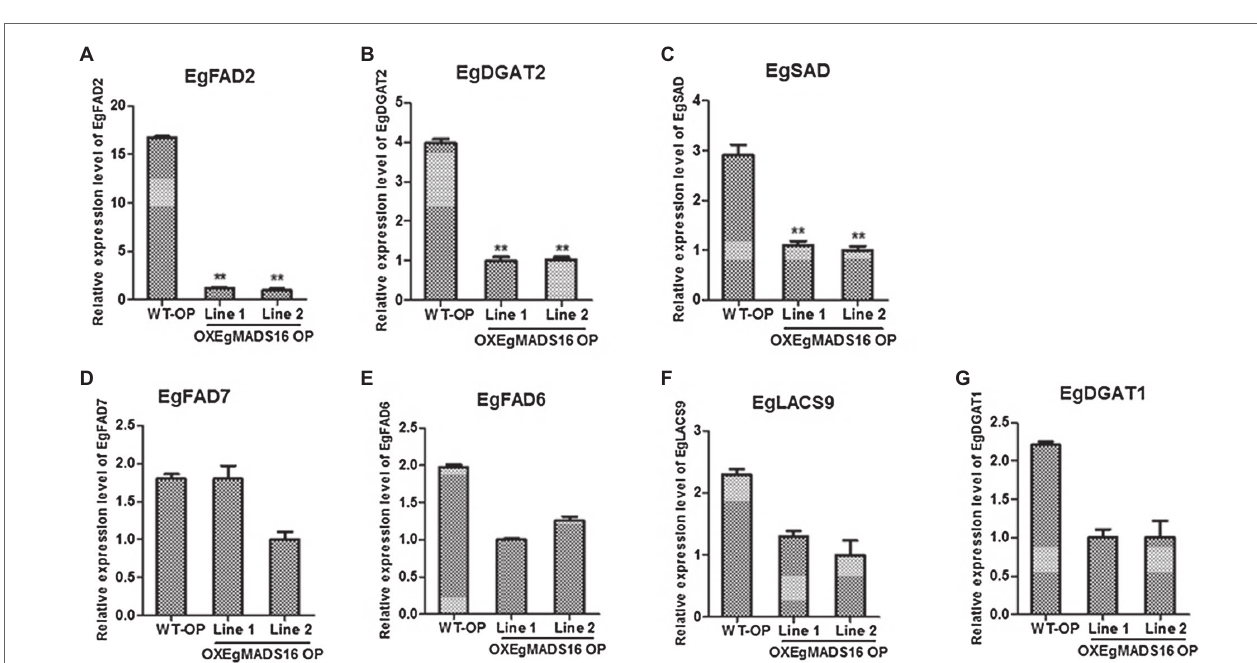
FIGURE 7 | Identification of downstream genes of EgMADS16 protein. (A–G) The relative expression level of EgFAD2 (A) , EgDGAT2 (B) , EgSAD (C) , EgFAD7 (D) , EgFAD6 (E) , EgLACS9 (F) , and EgDGAT1 (G) in WT and OXEgMADS16 oil palm embryonic callus. The values are the means ± SD ( n = 3). “**” represents a highly significant difference ( p < 0.01) using Student’s t